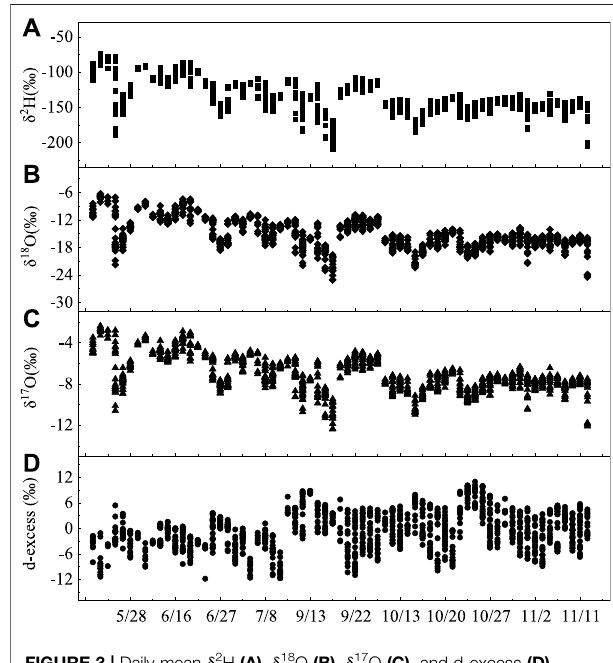
FIGURE 3 | Daily mean δ 2 H (A) , δ 18 O (B) , δ 17 O (C) , and d-excess (D) atmospheric water vapor variations near the surface during the entire sampling period in Lanzhou,